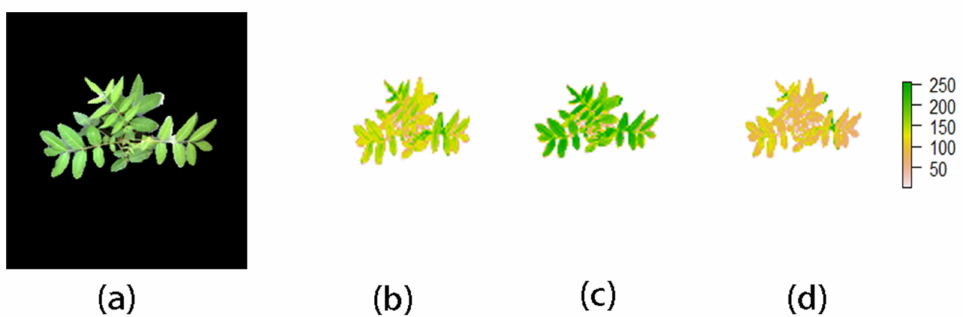
Figure 4. Image segmentation results of T. sinensis seedlings based on the U-Net model. T. sinensis seedling original image ( a ), R channel image ( b ), G channel image ( c ), B channel image ( d ).